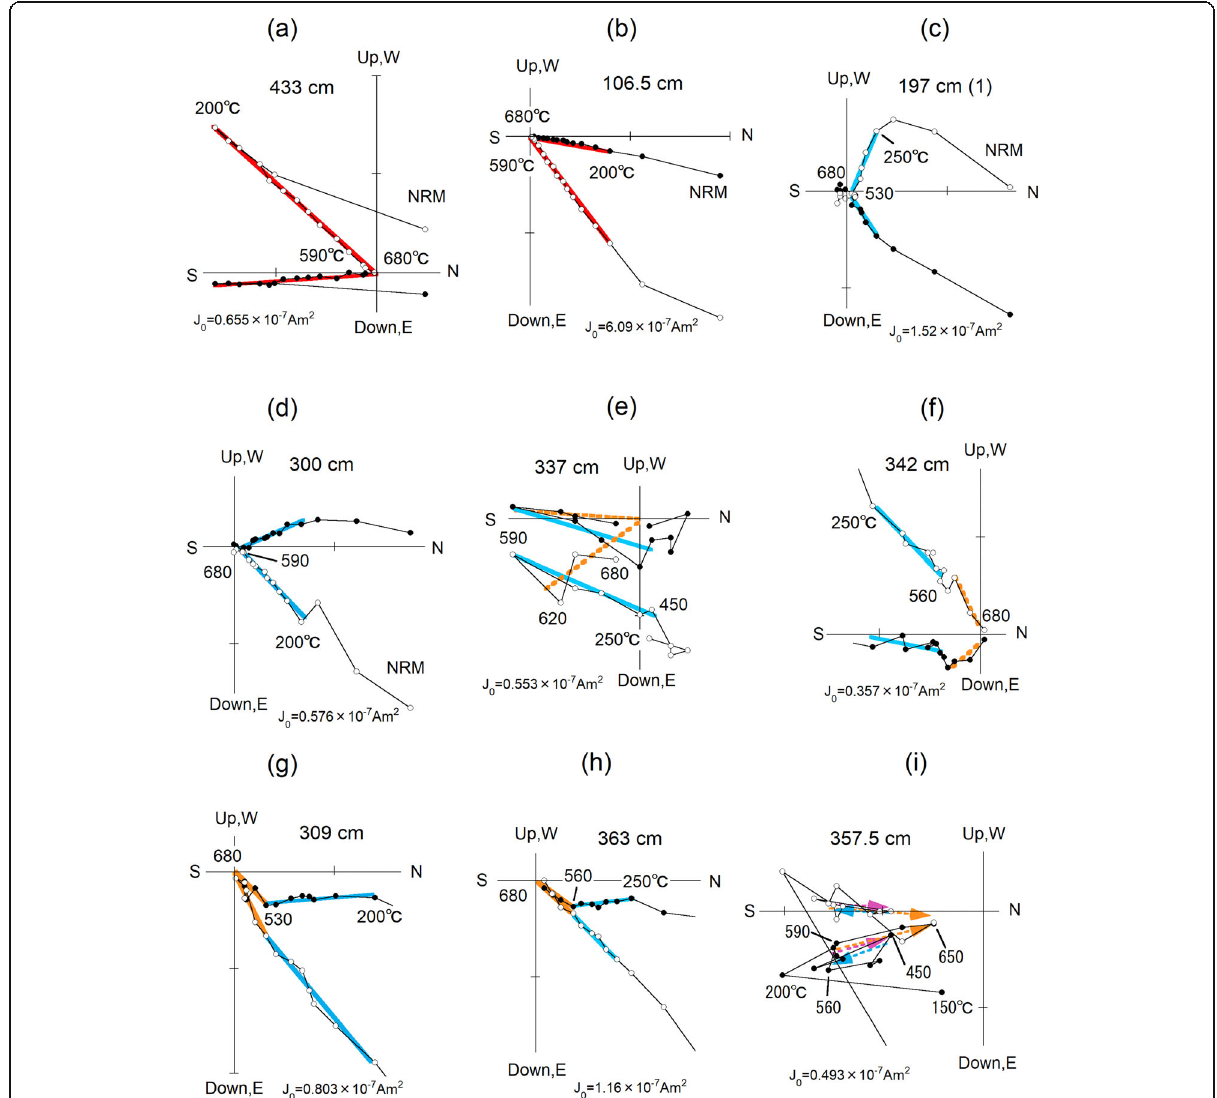
Fig. 3 Vector end-point diagrams. The solid/open circles show projections on the horizontal/vertical planes, respectively. Red lines in a , b show single normal/reverse components obtained from most of samples. In c to h , blue/orange lines show magnetite-/hematite-carried components, respectively. i Pink/blue/orange arrows show low/middle/high-temperature components,